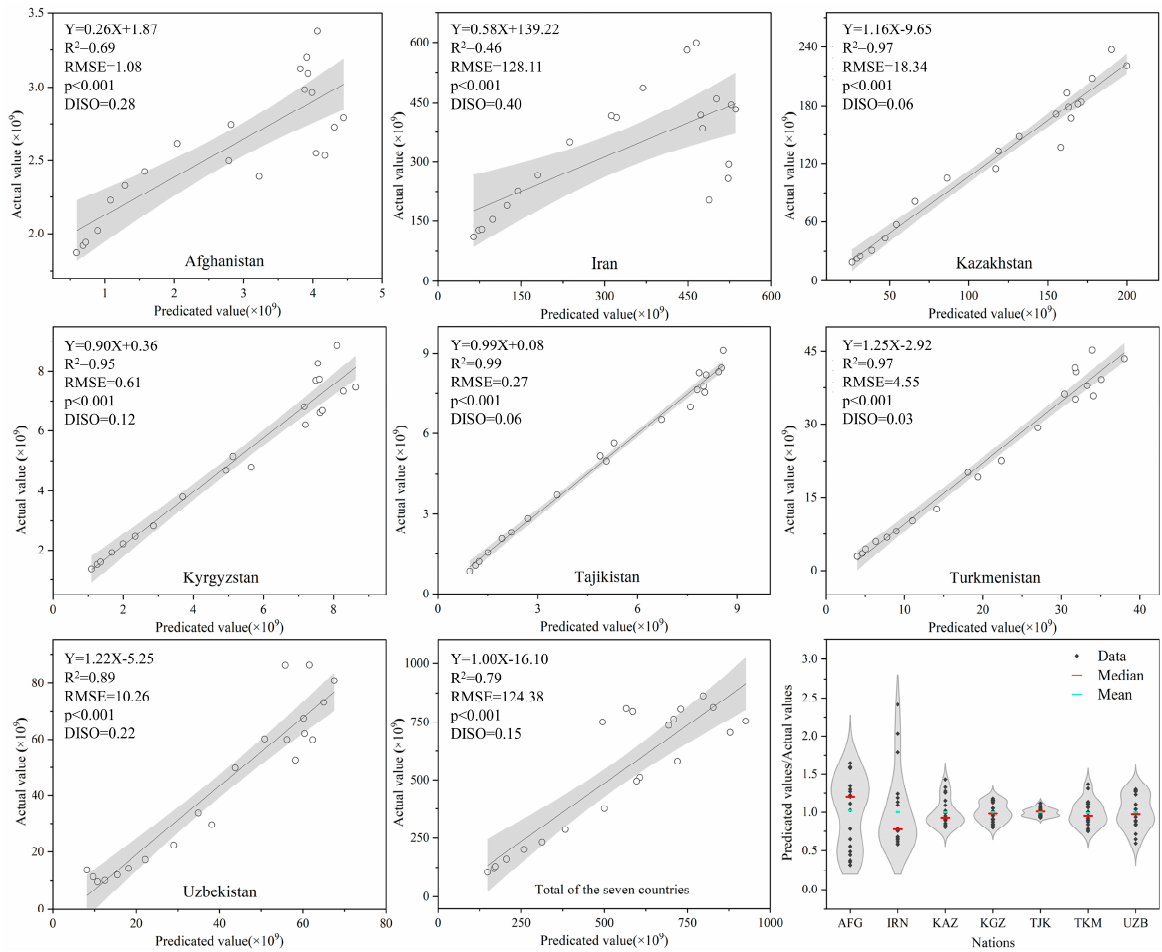
Figure 4. The actual GDP versus projected GDP for seven countries in the ASB,